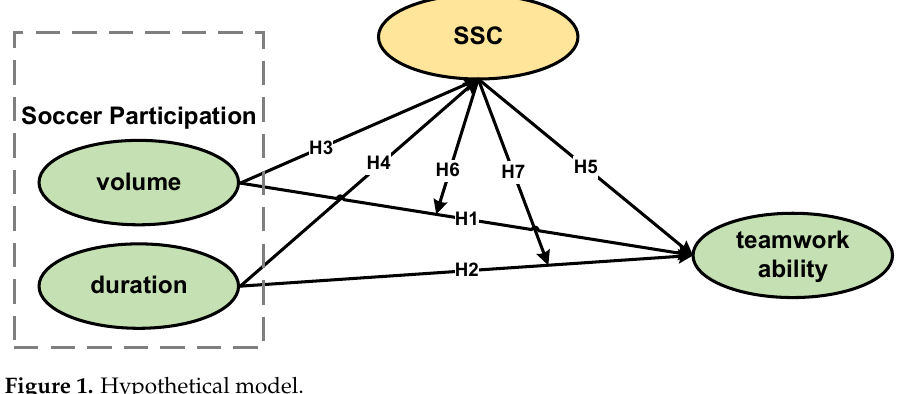
Figure 1. Hypothetical model.